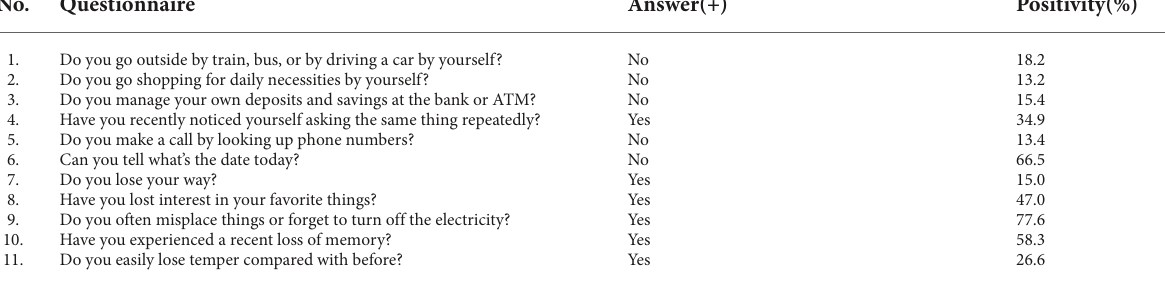
TABLE 4 Positivity of each questionnaire to detect dementia in the